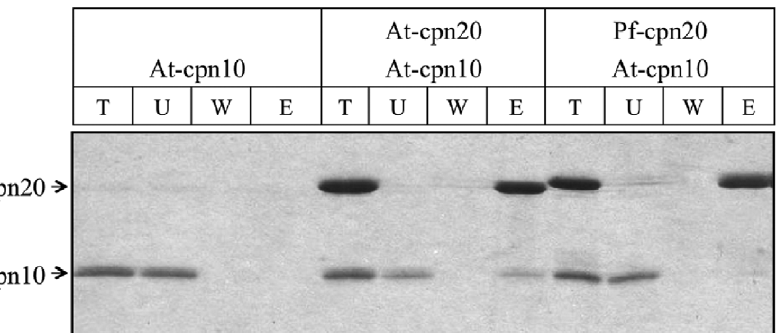
Figure 4. Pf-cpn20 does not form hetero-oligomers with At-cpn10. Interaction between Cpn20 and Cpn10 was measured using a pulldown assay. His-tagged At- or Pf-cpn20 was incubated with At-cpn10 and bound to Ni 2 + beads as described in Materials and Methods. Equivalent aliquots of 12 m l from the total sample (T), unbound fraction (U), fourth wash (W), and bound fraction (B) were analyzed by SDS-PAGE and stained with Coomassie Brilliant Blue